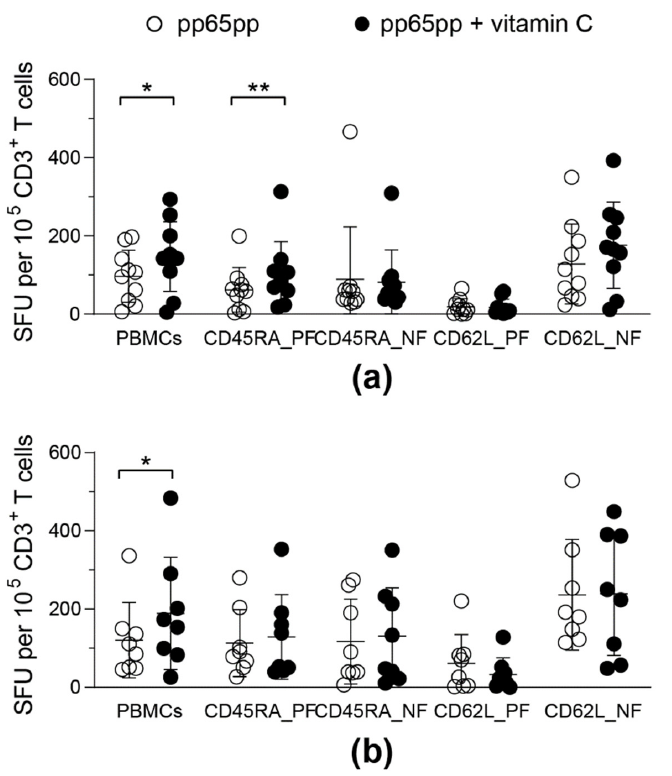
Figure 6. Vitamin C enhances IFN- γ secretion in CD45RA + T cells. After PBMC isolation, different T-cell fractions (5 × 10 4 effector cells) were isolated using CD45RA and CD62L immunomagnetic MicroBeads and collecting the respective positive (PF) and negative fractions (NF). Half of all cell fractions were pre-treated with vitamin C for ( a ) 1 day or ( b ) 3 days. Hereinafter all cell fractions were stimulated with pp65pp overnight. CMV-specific T-cell responses were determined by IFN- γ ELISpot. Shown are spot-forming units (SFU) per 10 5 CD3 + cells after 1 day of incubation with (pp65pp + vitamin C) or without (pp65pp) vitamin C and subsequent stimulation with pp65. Each symbol represents a different donor ( n = 8–10). Wilcoxon signed rank test was used to determine statistical significance between the same cell fractions; only statistically significant differences are shown (* p < 0.05; ** p < 0.01). 4. Discussion Vitamin C plays an important role in immunologic processes of lymphocytes, which are, however, not yet fully understood [26]. An intake of 100–200 mg vitamin C per day by healthy individuals has been proven to be adequate to saturate the plasma concentrations, which are in the range of 50–80 µM, and were further shown to reduce the